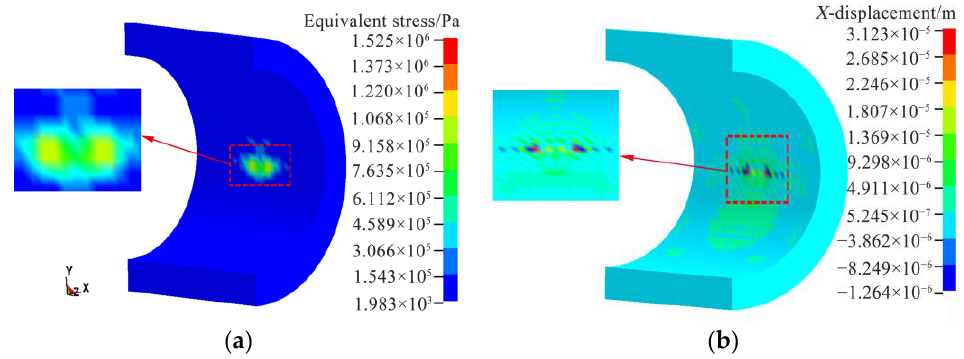
Figure 17. Circular tunnel section. ( a ) Equivalent stress peak value. ( b ) Peak displacement in X - direction.